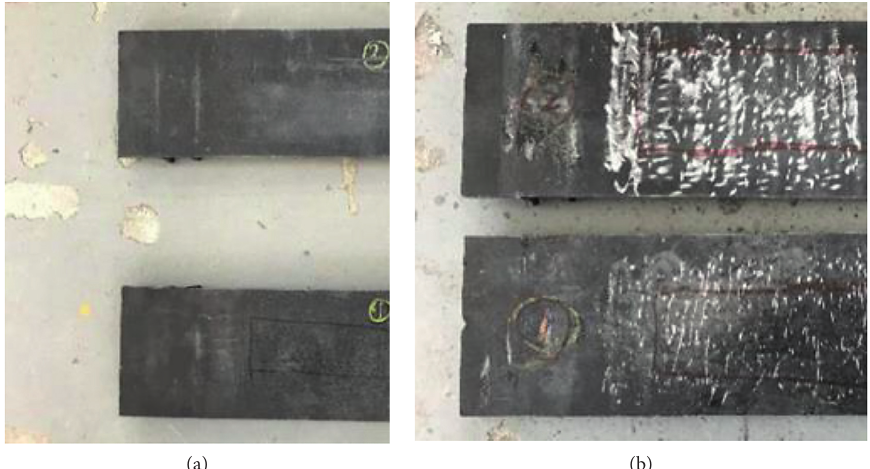
Figure 3: Changes in friction steel plates before and after treatment. (a) Friction steel plate before treatment. (b) Friction steel plate after